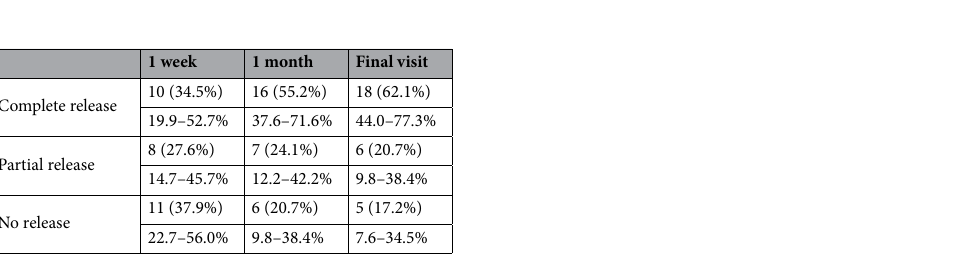
Table 2. Rates of VMT release. Number and (%) of patients with each outcome category, and 95% confidential interval (CI) for the percentage.